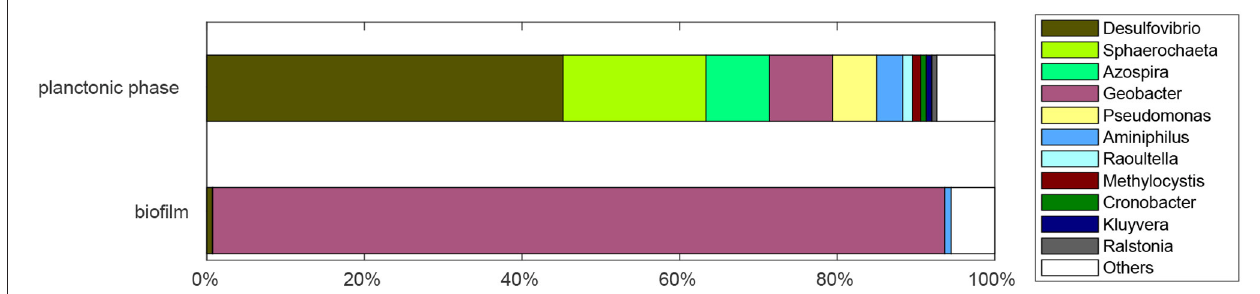
FIGURE 5 | Relative abundance of bacterial genera found in biofilm and planktonic phase of the reactor after 2 months of continuous operation with 1.8mM glycerol inlet concentration, an anode potential of 0.2V, and a residence time of 28.8h. that the population is stable after transfer into a glycerol-fed